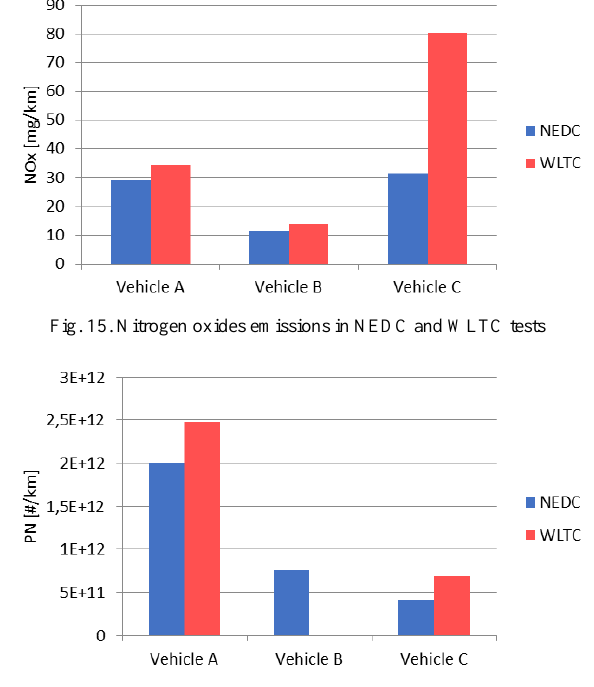
Fig. 16. Particle emissions in NEDC and WLTC tests